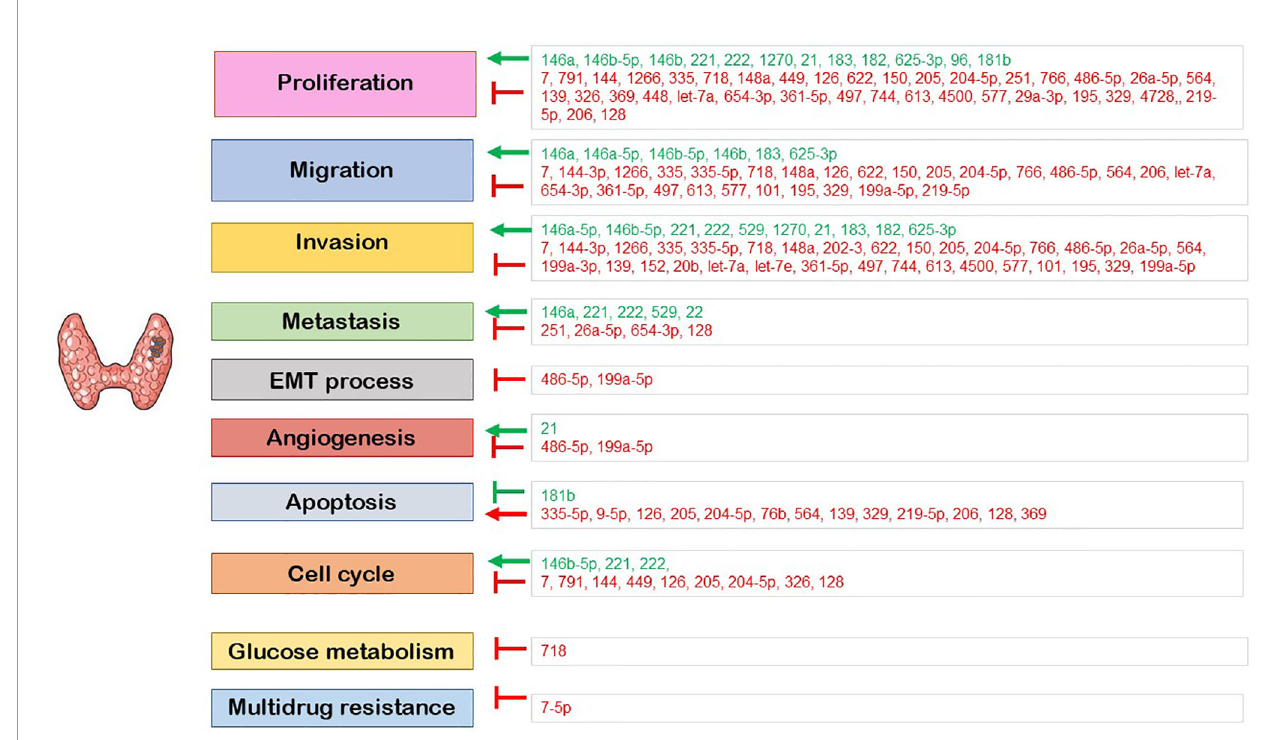
FIGURE 2 | The role of the deregulated miRNA in the regulation of cellular processes. Red: downregulated miRNA; green: upregulated miRNA; ⟶ : induction; ⊣ :